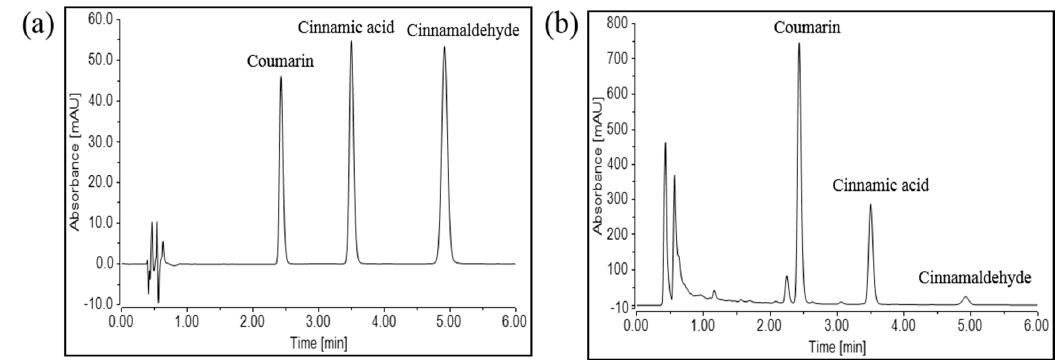
Figure 5. Quantification of chemicals in WECC using UHPLC. UHPLC chromatograms of three standards ( a ) and WECC ( b ). The three peaks represented coumarin (2.430 min, y = 0.0013 x + 8.7147, r 2 = 0.9987), cinnamic acid (3.500 min, y = 0.0047 x − 0.5087, r 2 = 0.9992), and cinnamaldehyde (4.922 min, y = 0.0058 x − 0.0110, r 2 = 1.0000) sequentially.